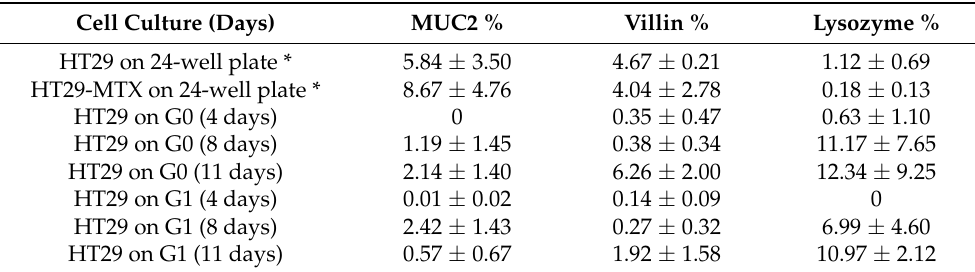
Table 2. Image analysis of immunofluorescence on HT29 cells as well as HT29 differentiated with MTX on different